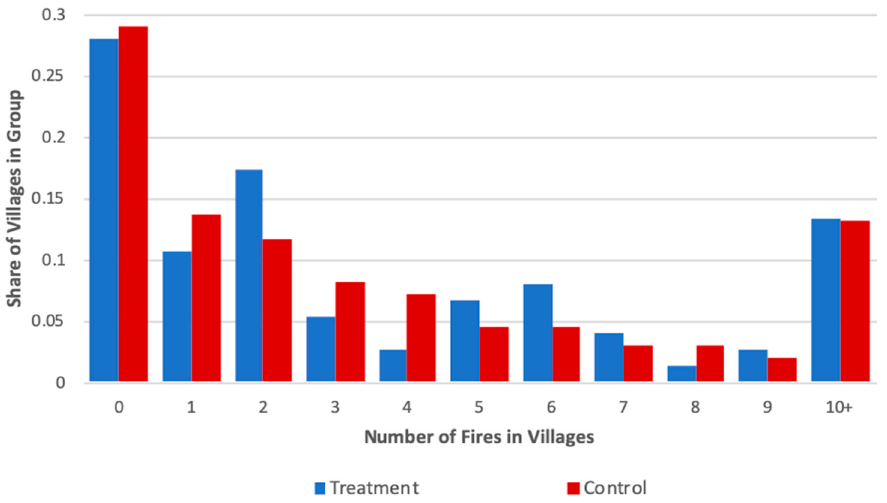
Figure 2. Share of Treatment and Control Villages, by Number of Fires.